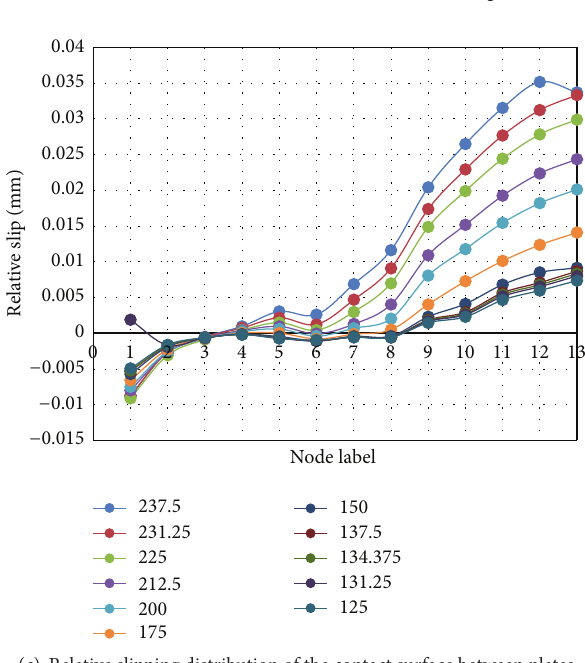
(b) Tangential contact stress distribution